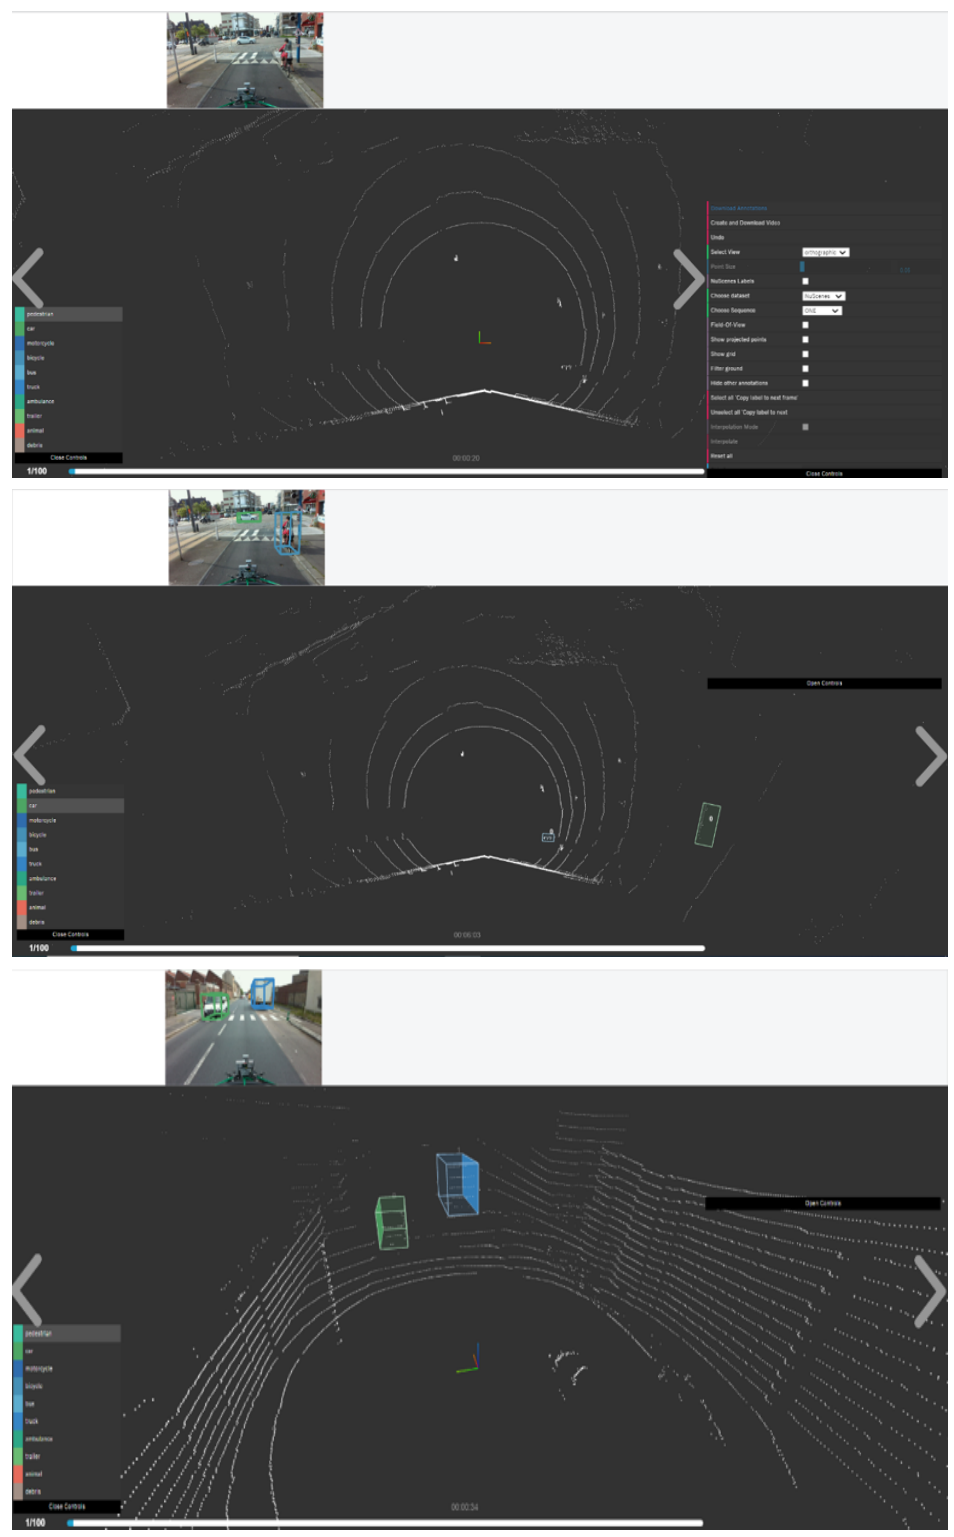
Figure 13. Some annotations examples in ESRORAD dataset. Top line : BAT 3D tool view before annotation, middle and bottom up line : BAT 3D tool view after